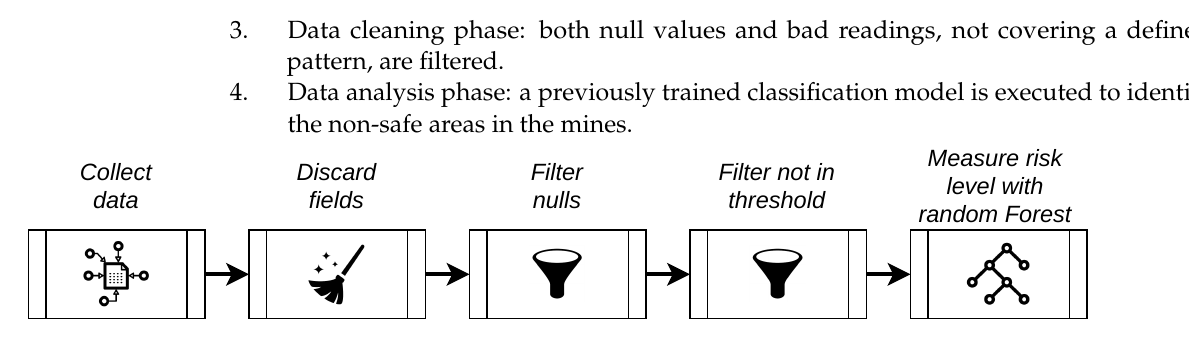
Figure 2. Pipeline conceptualised for the scenario in which the diverse steps proposed are